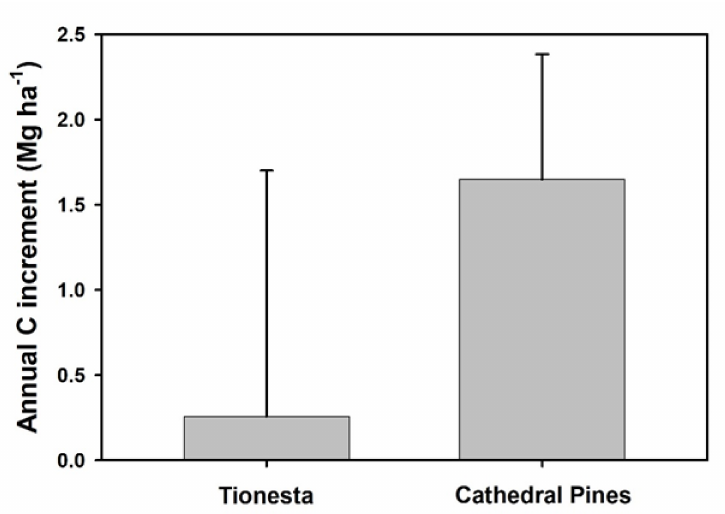
Figure 5. Annual carbon accumulation rates (Mg ha − 1 ) across six years at Tionesta (ref. [17]), n = 289) and across ten years ( n = 55) at Cathedral Pines. Bars show median rate; error bars indicate 75th